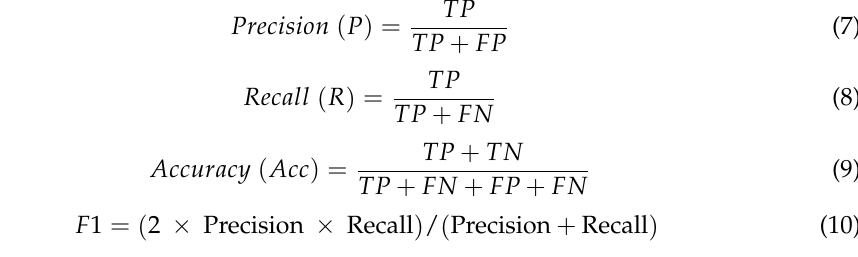
F 1 = ( 2 × Precision × Recall ) / ( Precision + Recall